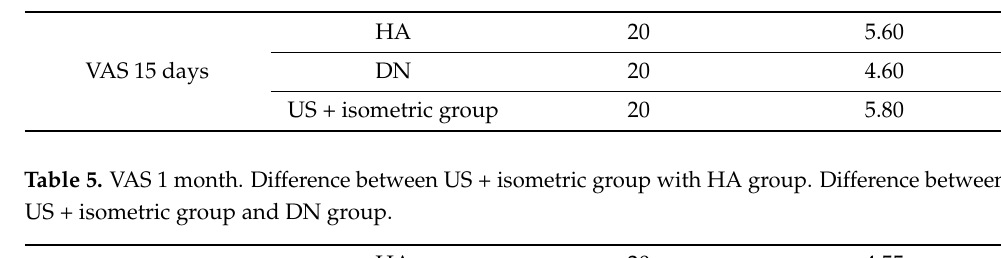
Table 4. VAS 15 days. Difference between HA group and US + isometric group. Difference between DN group and US + isometric group.